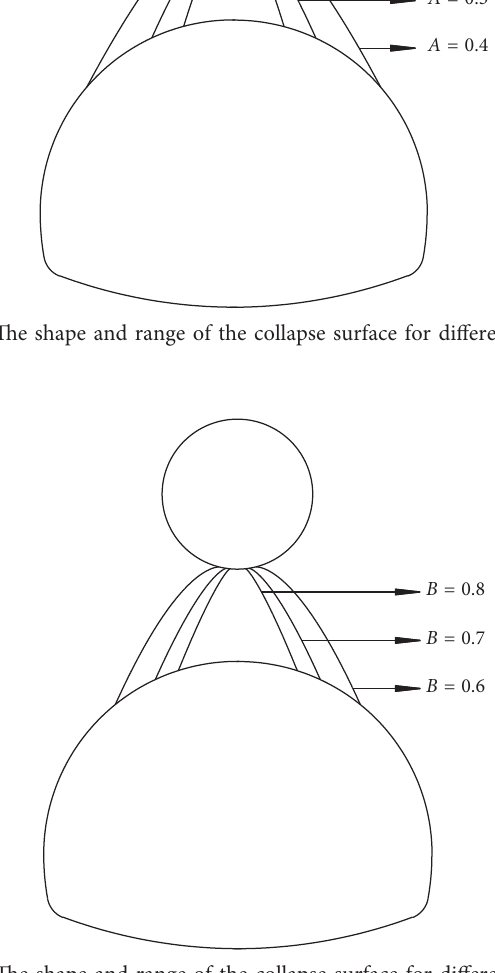
Figure 5: The shape and range of the collapse surface for different values of B